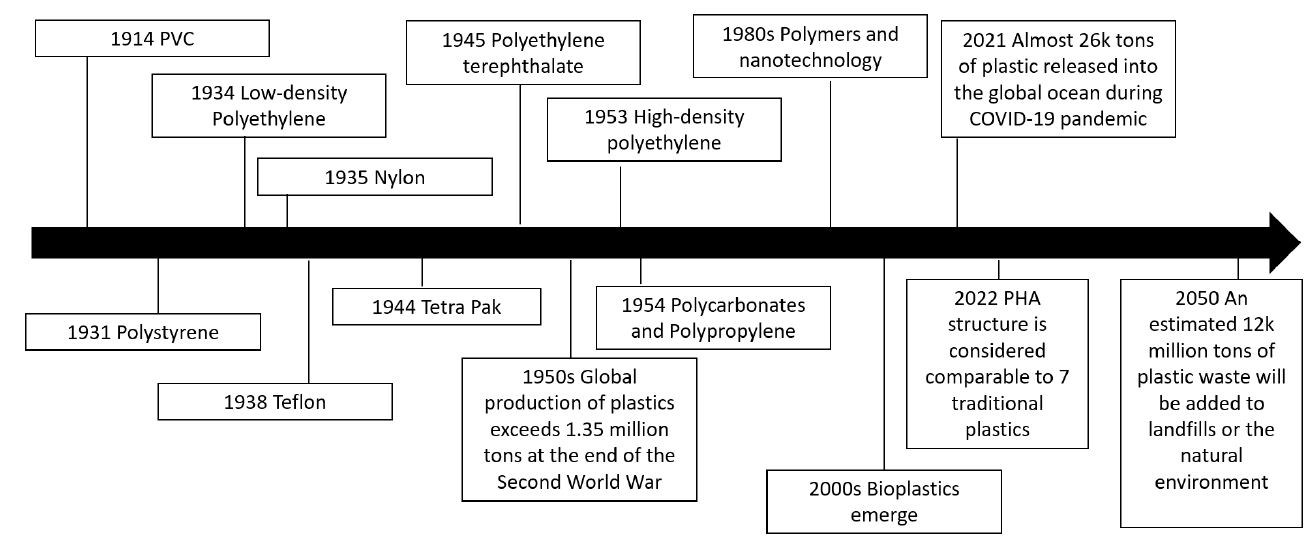
Figure 1. Milestones over the last century summarizing how bioplastics fit into the plastics industry.